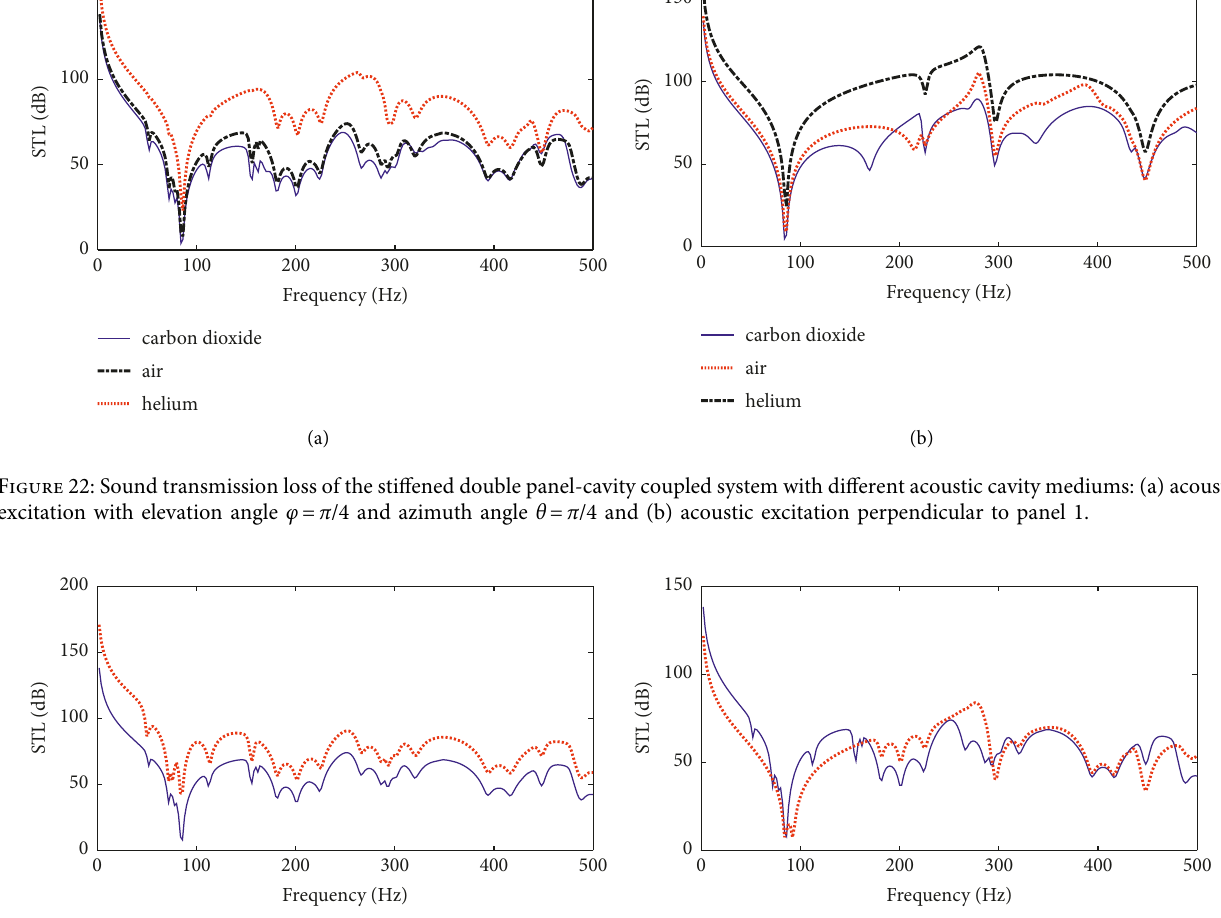
ρ =1.21 kg/m 3 ;c=343 m/s ρ =0.1664 kg/m 3 ;c=343 Figure 23: Sound transmission loss of the stiffened double panel-cavity coupled system with different acoustic cavity medium constant: (a) different density and (b) different acoustic